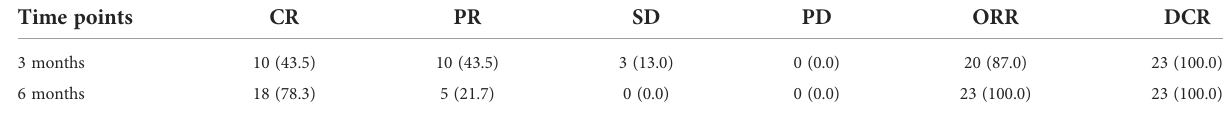
TABLE 2 Clinical response at 3 and 6 months after